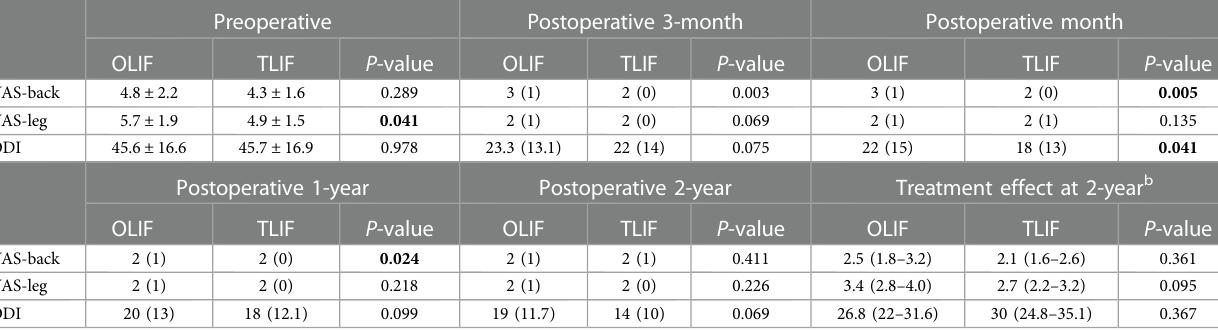
TABLE 2 Comparisons of VAS and ODI between OLIF ( n =40) and TLIF ( n =41) groups a .